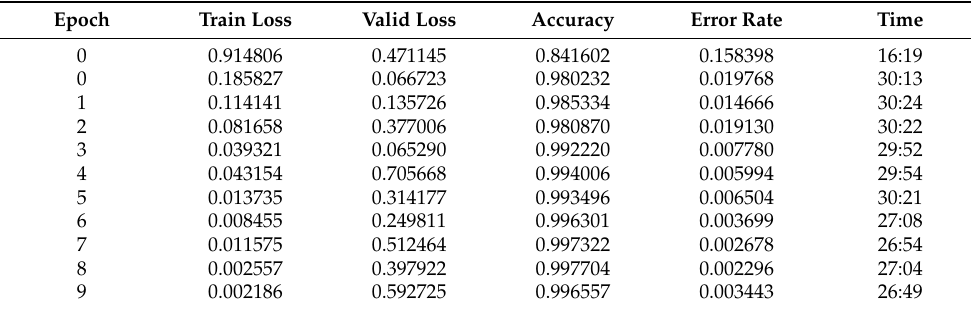
Table 5. Results of the SqueezeNet 1-0.